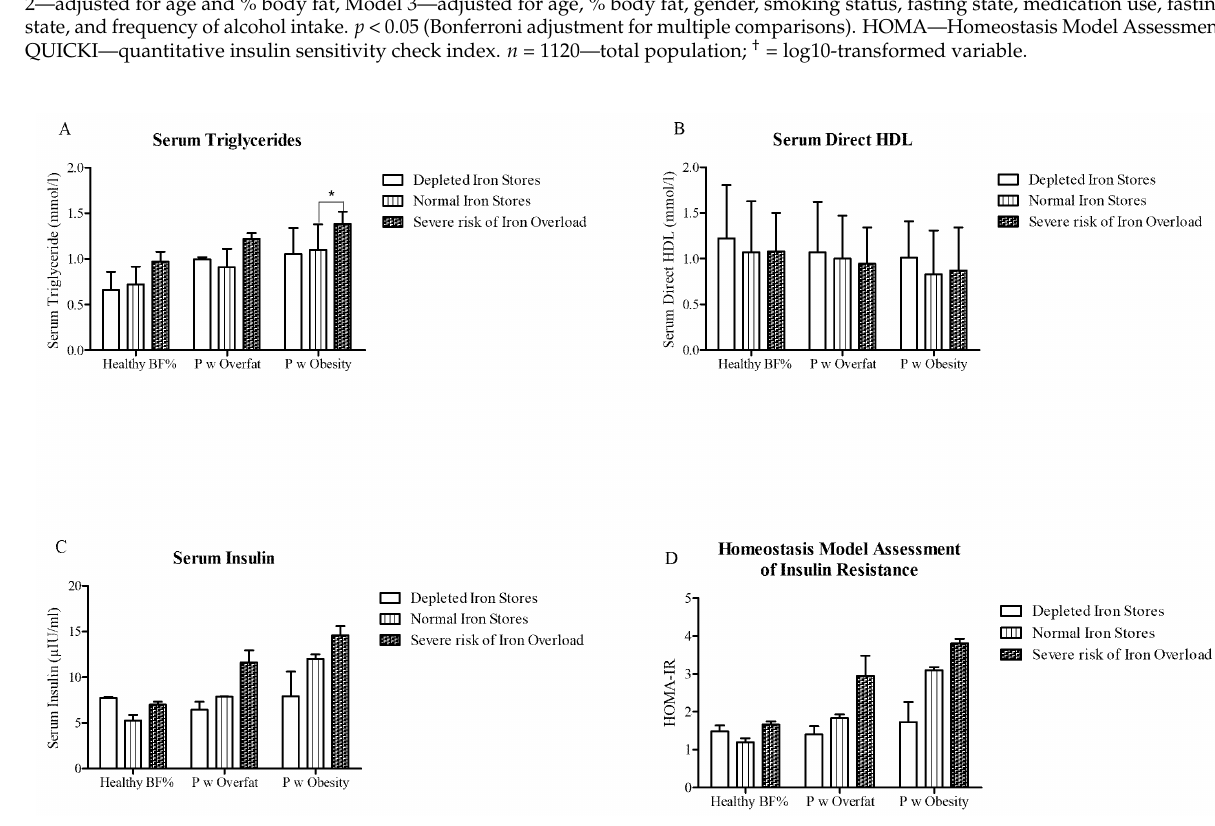
X 2 test of categorical variables: risk of metabolic syndrome determined based on National Cholesterol Education Pro- gramme’s Adult Treatment Panel III criteria for metabolic syndrome 2001—participants presenting with three or more risk factors are diagnosed with Metabolic syndrome. Details of diagnosis criteria detailed above. Table includes partici- pants for whom all criteria for cut-off points were available based on analysis of fasted blood samples. ( n = 853). 4. Discussion This study describes the iron status of a cohort of individuals classified as having either a healthy % BF or as having overfat or obesity using iron and inflammation associ- ated biomarkers and investigates relationships between disturbed iron homeostasis and metabolic health. Results indicate that a higher % BF amongst males is associated with disturbances in iron homeostasis, presenting as elevated serum hepcidin and serum ferri- tin, with an increased prevalence of those at severe risk of iron overload. Serum hepcidin levels were elevated in those within the upper categories of % BF, with a related increase